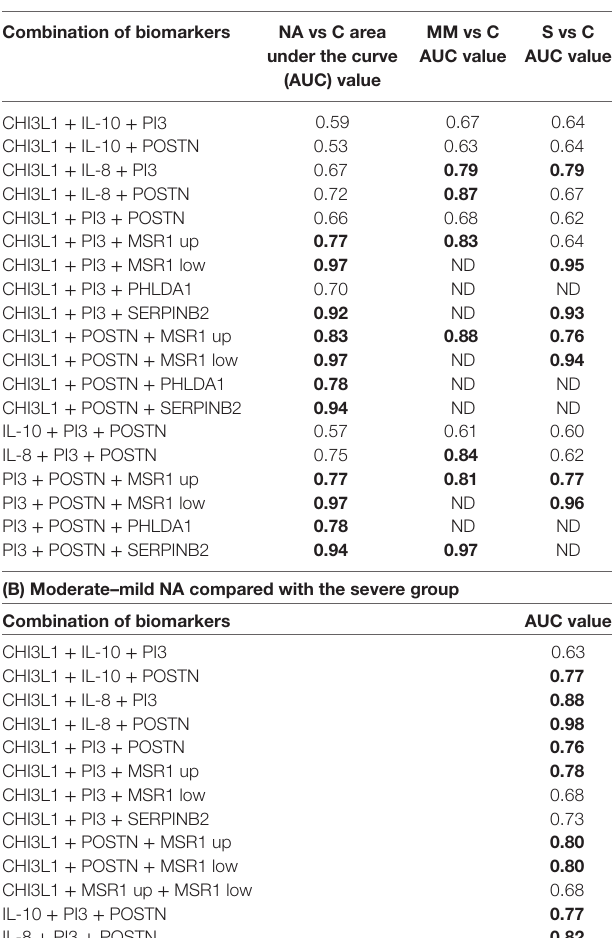
TaBle 4 | Receiver operating characteristic (ROC) curve analysis of the protein expression combining three biomarkers. (a) na compared with the c combination of